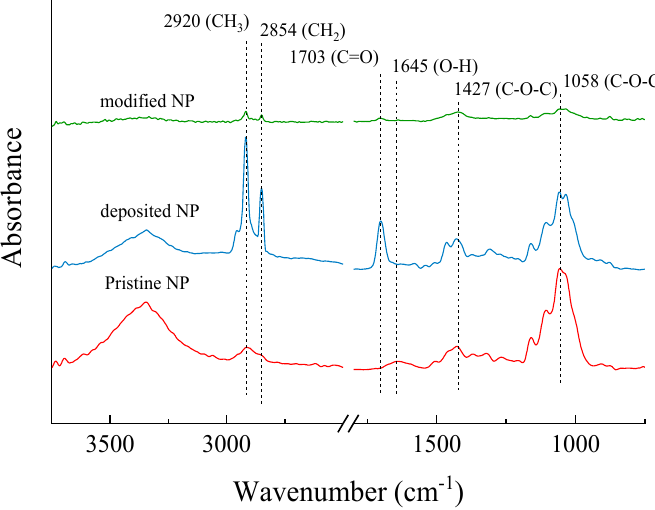
Figure 5. ATR-FTIR spectra of pristine, deposited NP and modified NP.